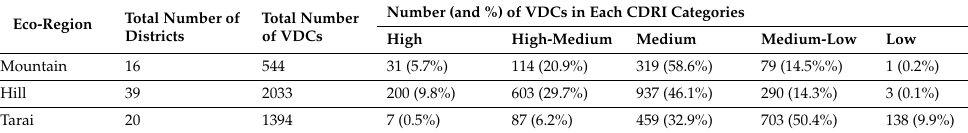
Figure 3. Spatial distribution of CDRI scores. Table 5. Distribution of village development committees (VDCs) and municipalities in each CDRI categories across the ecoregion .